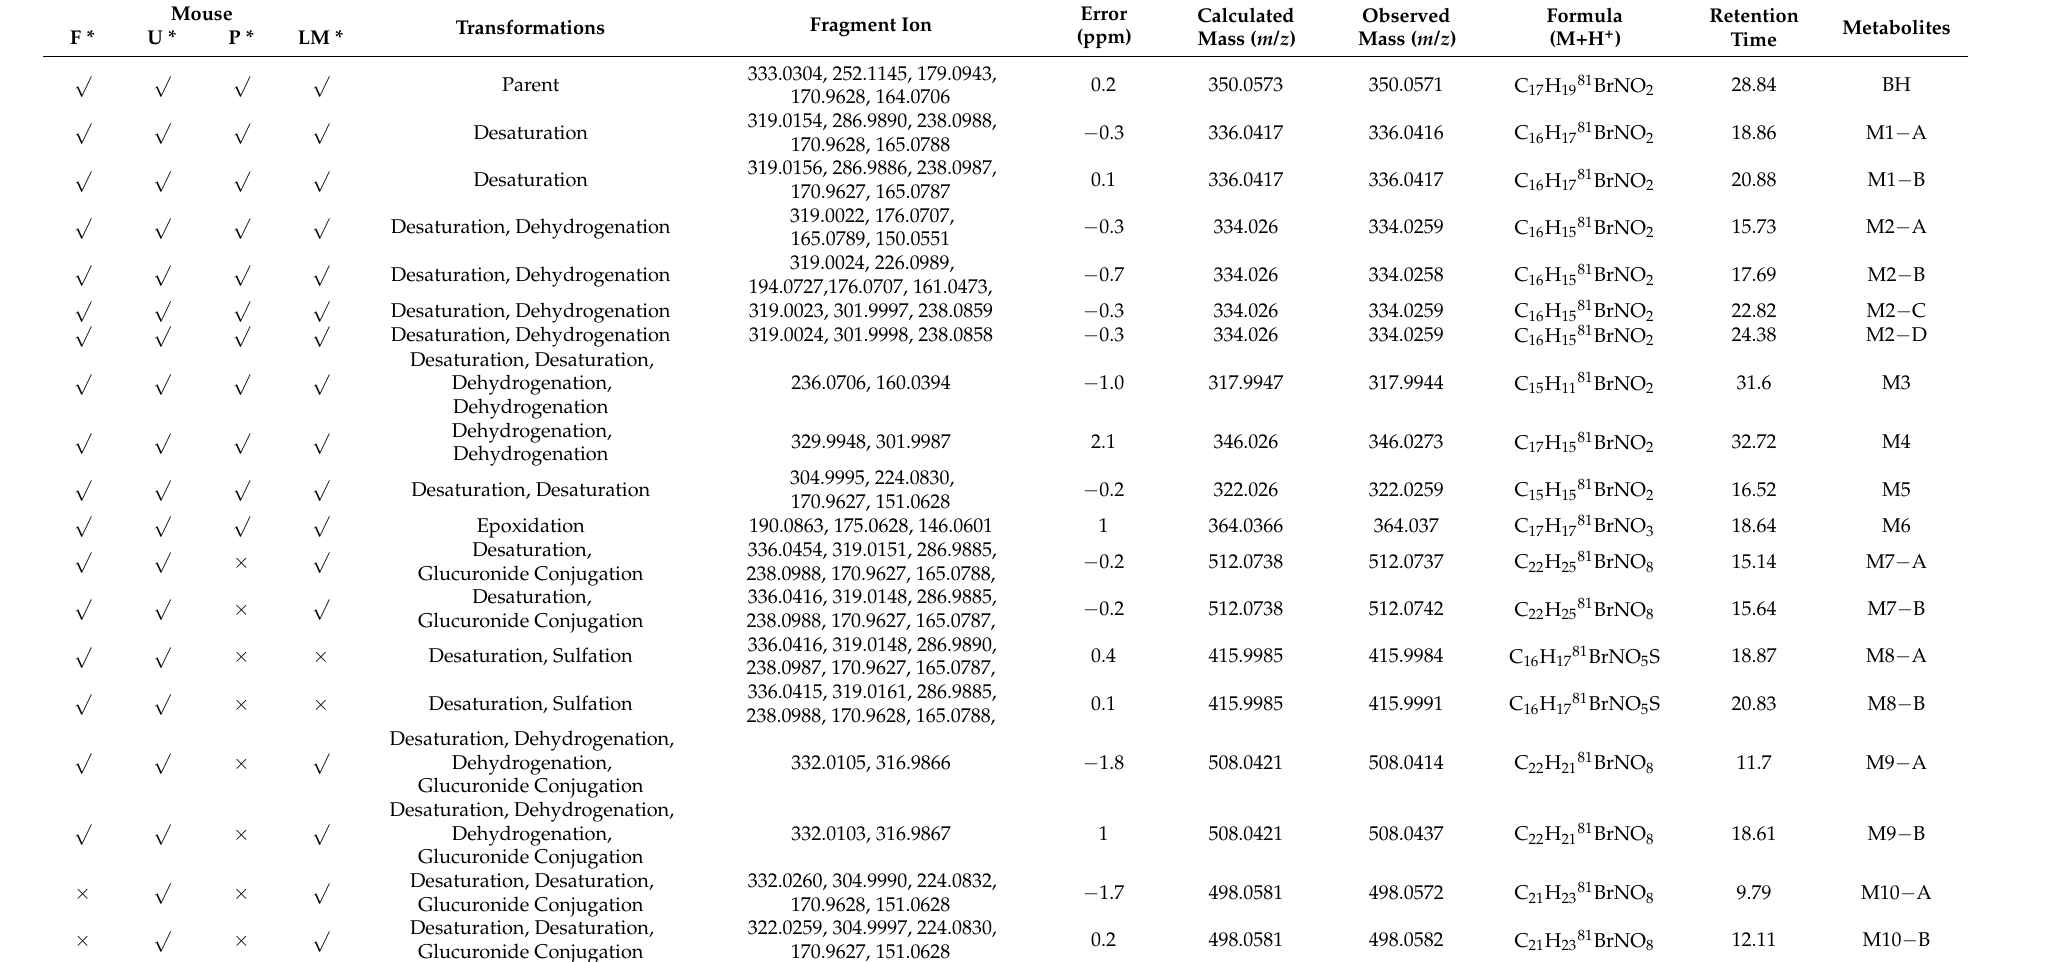
Table 2. Metabolite characterization of 1 − (3 (cid:48) − bromophenyl) − heliamine by UHPLC − Q − Orbitrap −